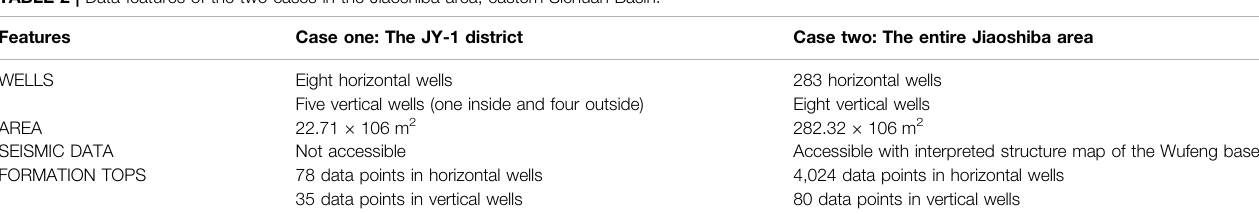
TABLE 2 | Data features of the two cases in the Jiaoshiba area, eastern Sichuan